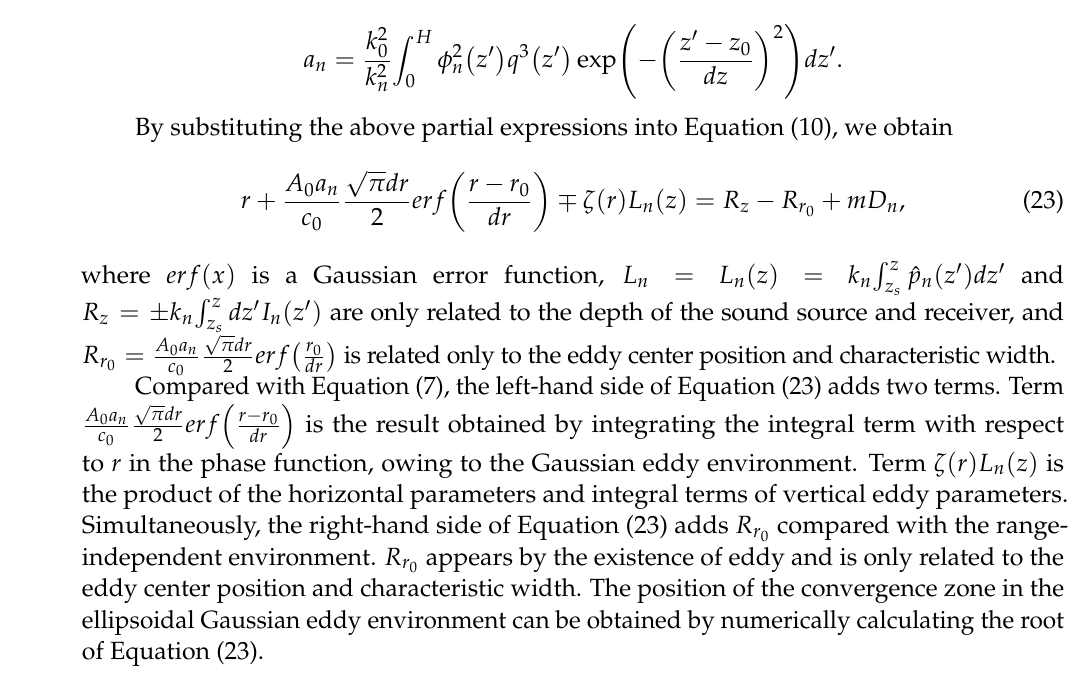
Figure 2. Depth variable function in linear variation case.